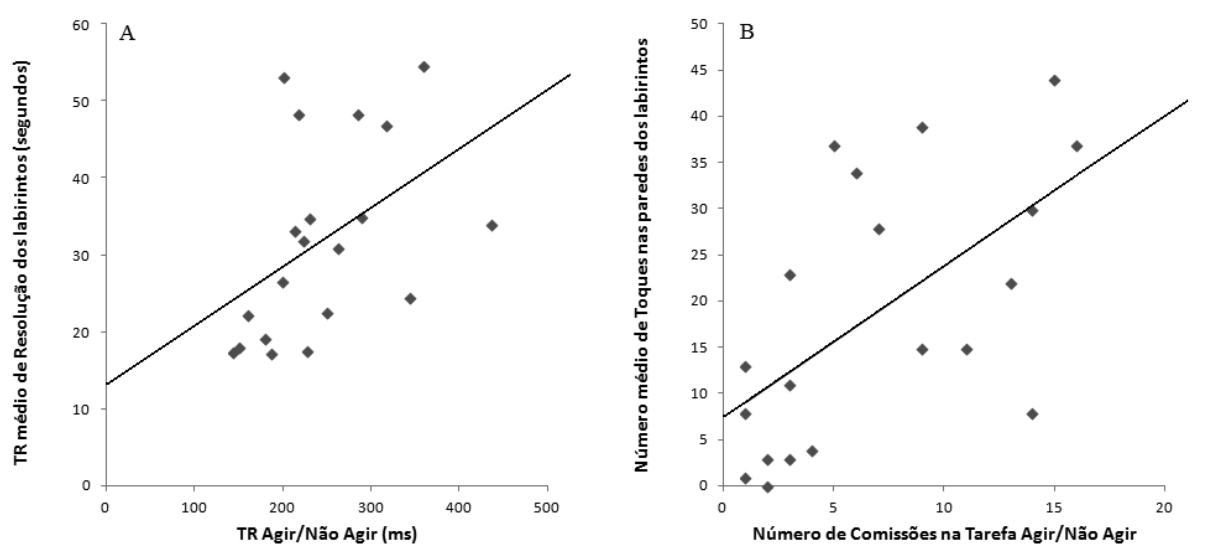
Figura 2 . (A) Regressão linear do tempo de reação TR (ms) na tarefa Agir/Não Agir em função do tempo médio de resolução dos labirintos (em segundos). (B) Regressão linear do número de erros de comissão na Tarefa Agir/Não Agir em função do número médio de toques nas paredes dos